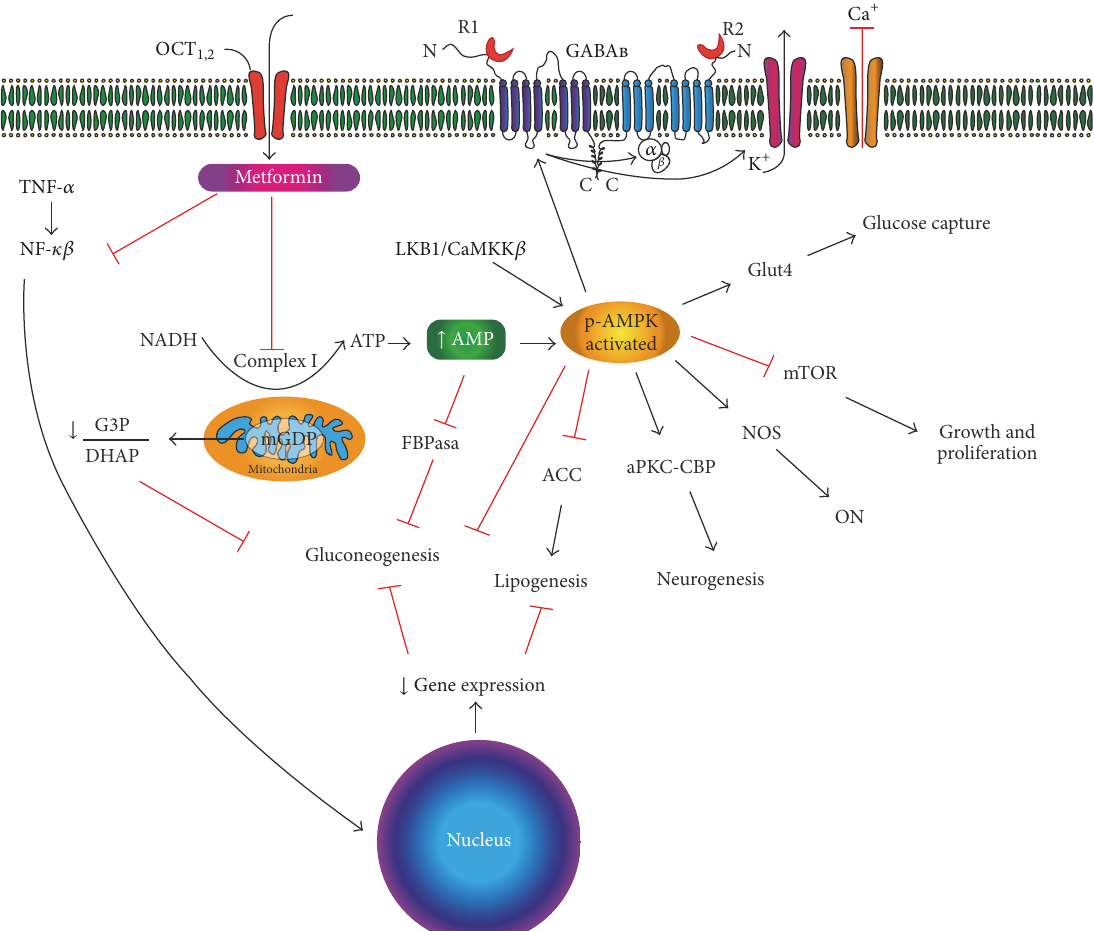
Figure 1: Different cellular pathways described for metformin function. Gluconeogenesis is inhibited due to changes in gene expression (such as for lipogenesis), FBPase inhibition, and changes in the ATP/AMP, G3P/DHAP, and lactate/pyruvate ratios. AMPK may exert different actionsinneuronsbecausetheydonothaveglycolyticenzymesand,thus,areducedabilitytostorenutrientsandrespondtoenergydeficitwith a higher risk of lactic acidosis. The GABA B receptor is involved in the effects of metformin through inducing hyperpolarization secondary to K + release and inhibition of Ca 2+ entry secondary to AMPK activation. OCT: organic cation (proton) transporter. G3P: glycerol-3-phosphate. mGDP: mitochondrial glycerophosphate dehydrogenase. DHAP: dihydroxyacetone phosphate. eNOS: endothelial nitric oxide synthase. ON: nitric oxide. aPKC: atypical protein kinase C. CBP: CREB binding protein. NF-KB: nuclear factor kappa beta. TNF- 𝛼 : tumor necrosis factor- alpha. FBPasa: fructose 1,6 bisphosphatase. ACC: acetyl CoA carboxylase. CaMKK 𝛽 : protein calmodulin-dependent kinase beta. mTOR: target of rapamycin in mammalian